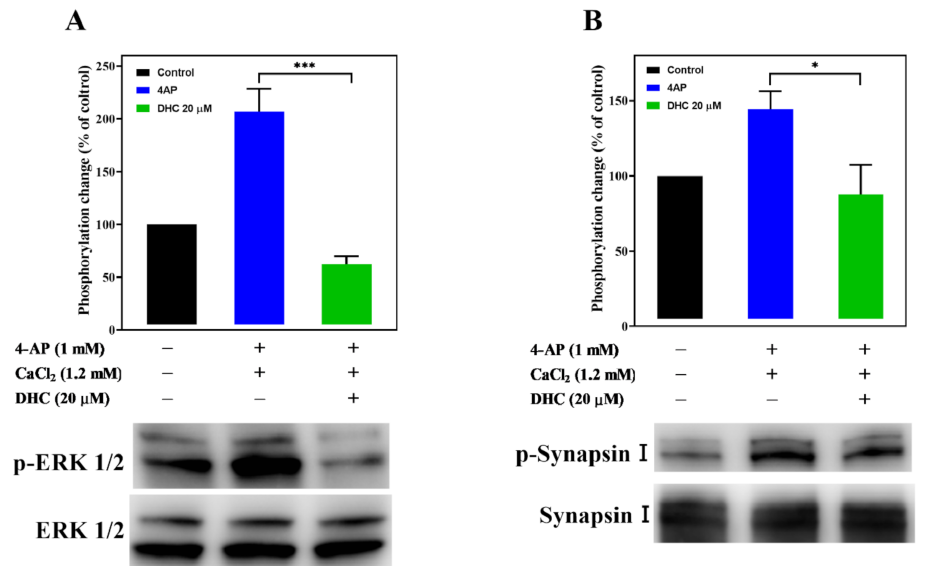
Figure 7. Effect of DHC on the activation of ERK1/2 and synapsin I phosphorylation. The expression levels of ( A ) p-ERK1/2, ERK1/2, ( B ) p-synapsin I, and synapsin I in synaptosomes were determined by immunoblotting. Data are the means ± SEM. For p-ERK1/2 expression, *** p < 0.001 versus the 4-AP alone group ( n = 3). For synapsin I expression, * p < 0.05 versus the 4-AP alone group ( n =